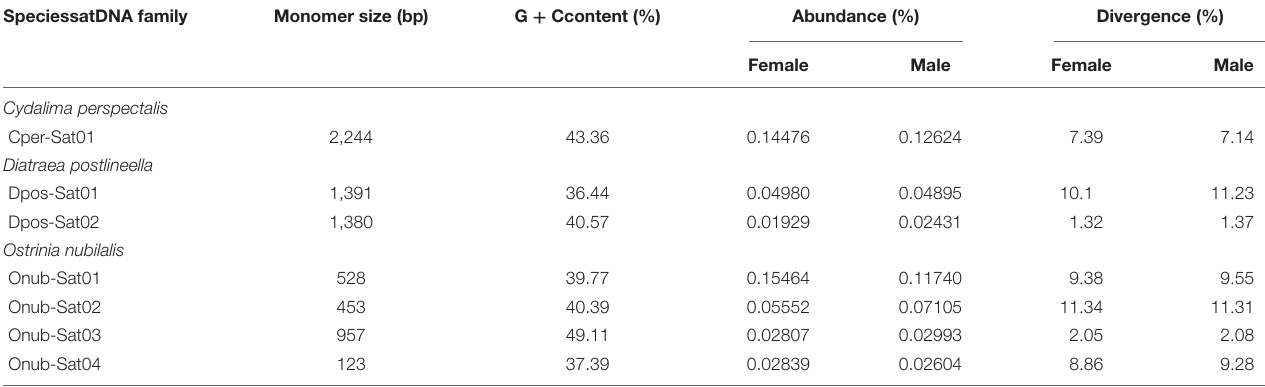
FIGURE 3 | W-chromosome painting in three species of Cambridae. (a,d,g) Intraspecies W-chromosome painting (green) and FISH with (TTAGG) n telomeric probe (red). Pachytene oocyte complements are shown in panel (a) Cydalima perspectalis , (d) Diatraea postlineella , and (g) Ostrinia nubilalis . In panels (b,c,e,f,h,i) , intraspecies and cross-species paintings of the W chromosome in the WZ bivalent of (b,c) C. perspectalis , (e,f) D. postlineella , and (h,i) O. nubilalis are compared. The probes are indicated directly in the images. Bar = 10 µ m. TABLE 1 | Main characteristics of SatDNA families identified in Crambidae